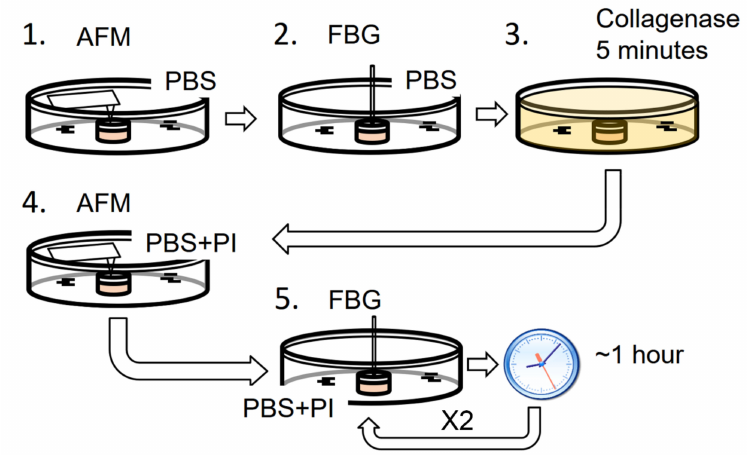
Figure 1. Measurement procedure: 1. The native thawed sample is measured by indentation-type atomic force microscopy (IT-AFM); 2. The sample is then subject to a stress relaxation measurement by the fiber Bragg grating (FBG) micro-indenter; 3. The sample is digested five minutes in a collagenase solution; 4. After rinsing, the digested sample is immersed in phosphate-bu ff ered saline (PBS) with protease inhibitor (PI) and measured again by IT-AFM approximately at the same locations as the previous measurement; 5. The digested sample is again measured by FBG micro-indenter at the same position as the previous measurement three times with an interval of one hour between the